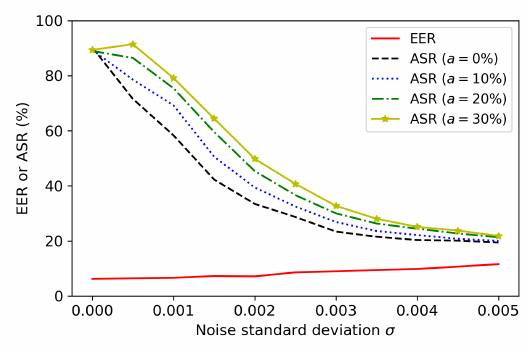
Figure 7. Performance of the adaptive FakeBob attacks with (cid:101) = 0.002 in GMM SV systems with